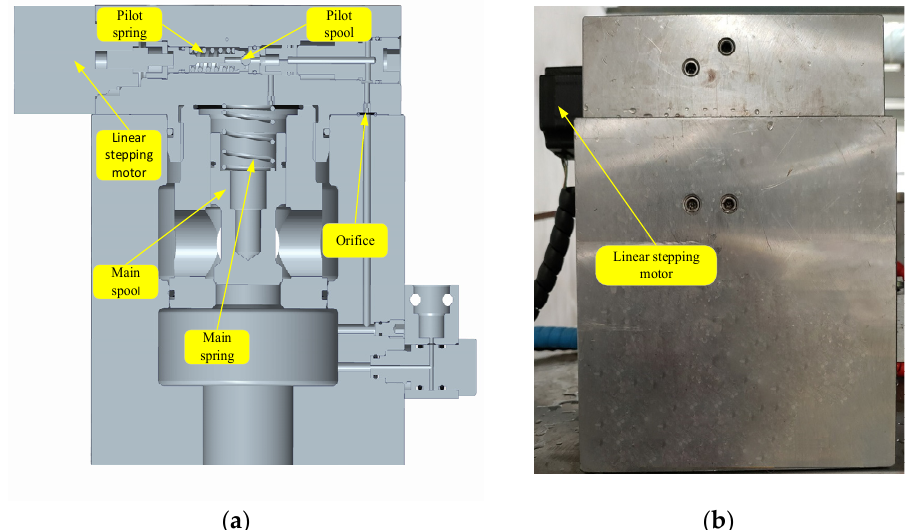
Figure 10. 3D and physical models of the digital relief valve: ( a ) 3D model; ( b ) physical model.